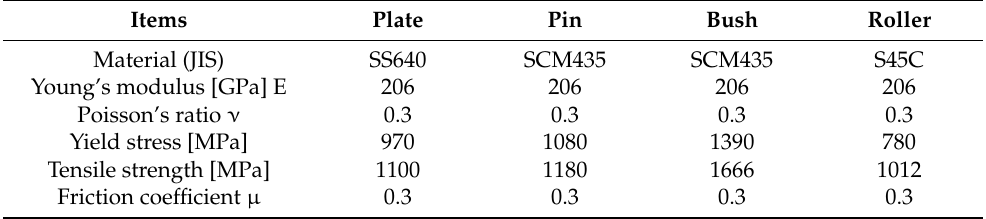
Table 3. Material properties of roller chain for FEM